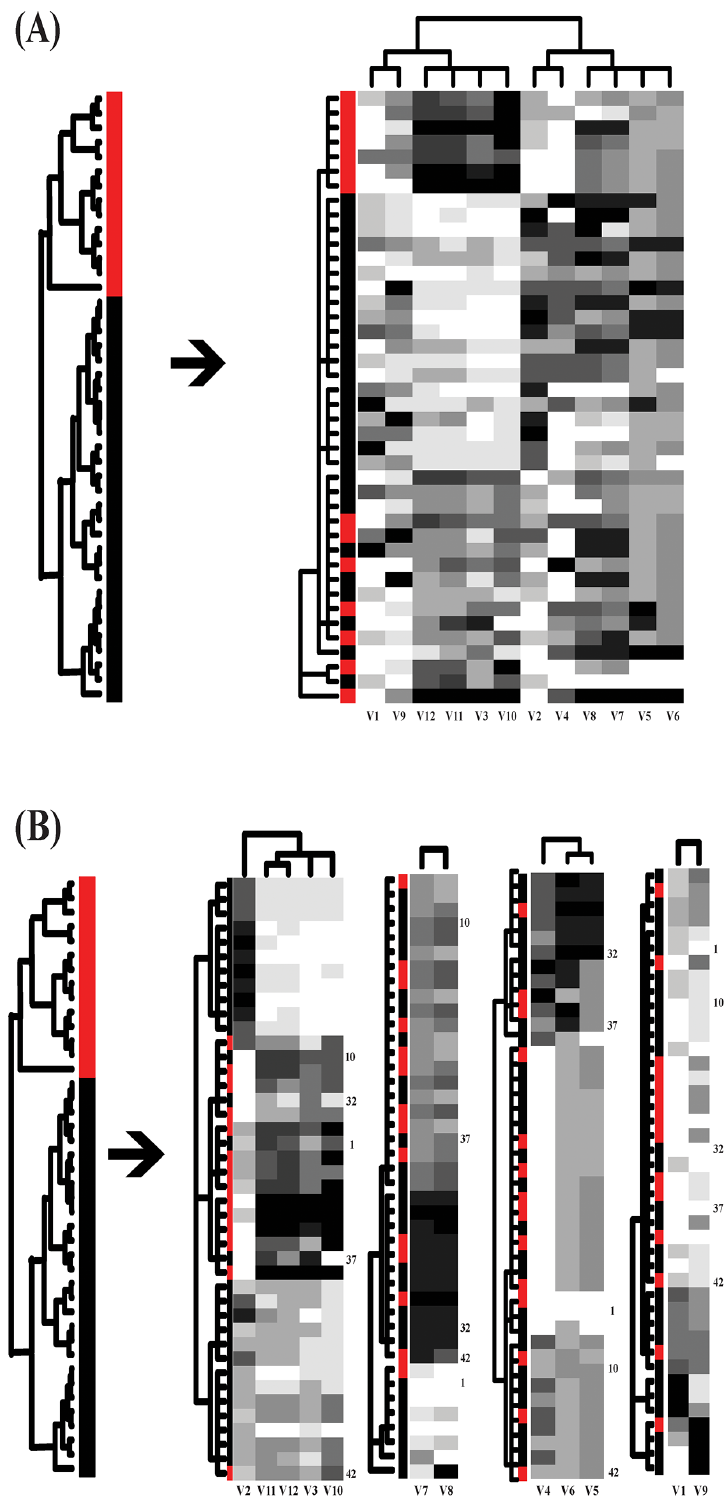
Fig 6. Information flows from response’s coarse-scale perspective. The information flows from the response to (A) #1&#2&#3&#4 synergistic feature-groups; (B) serial #2, #3, #1 and then #4 synergistic feature-groups.